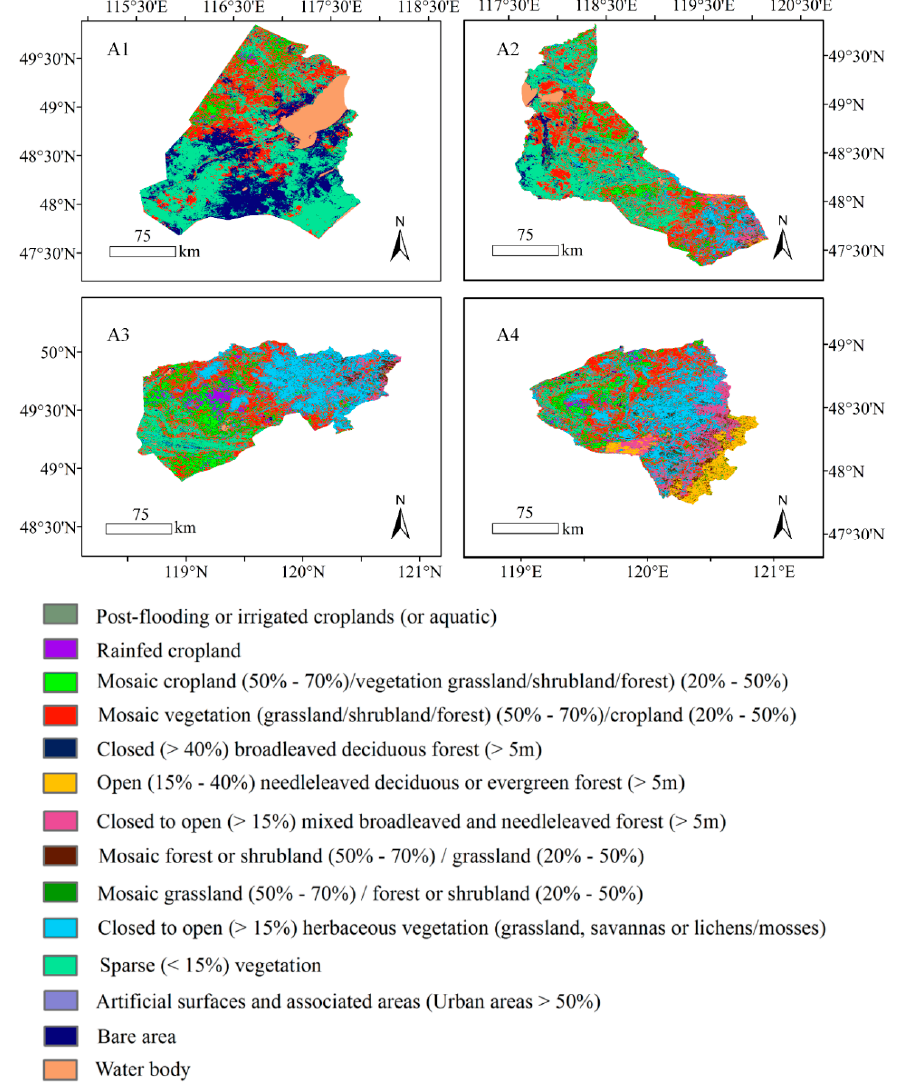
Figure 2. Land cover types of study region. Table 1. Land cover data of study region.